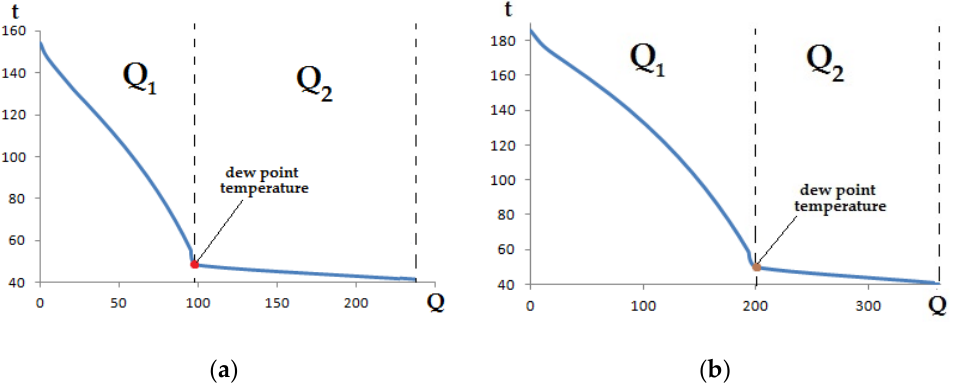
Figure 11. Calculated heat curve of the existing condenser for mode 1 ( a ) and mode 2 ( b ).